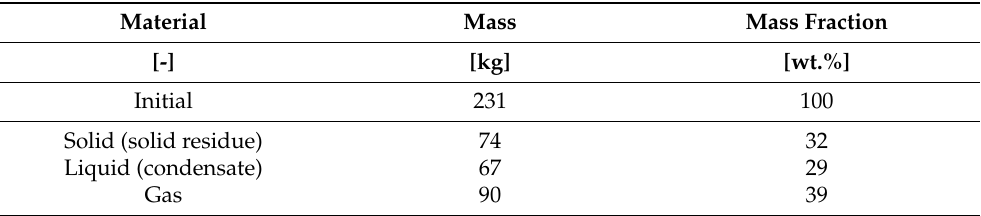
Table 2. Mass balance of the thermochemical conversion process. Material Mass Mass Fraction [kg]